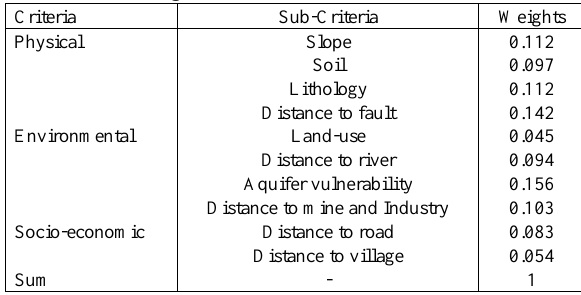
Table 2. Final weights of sub-criteria based on the AHP